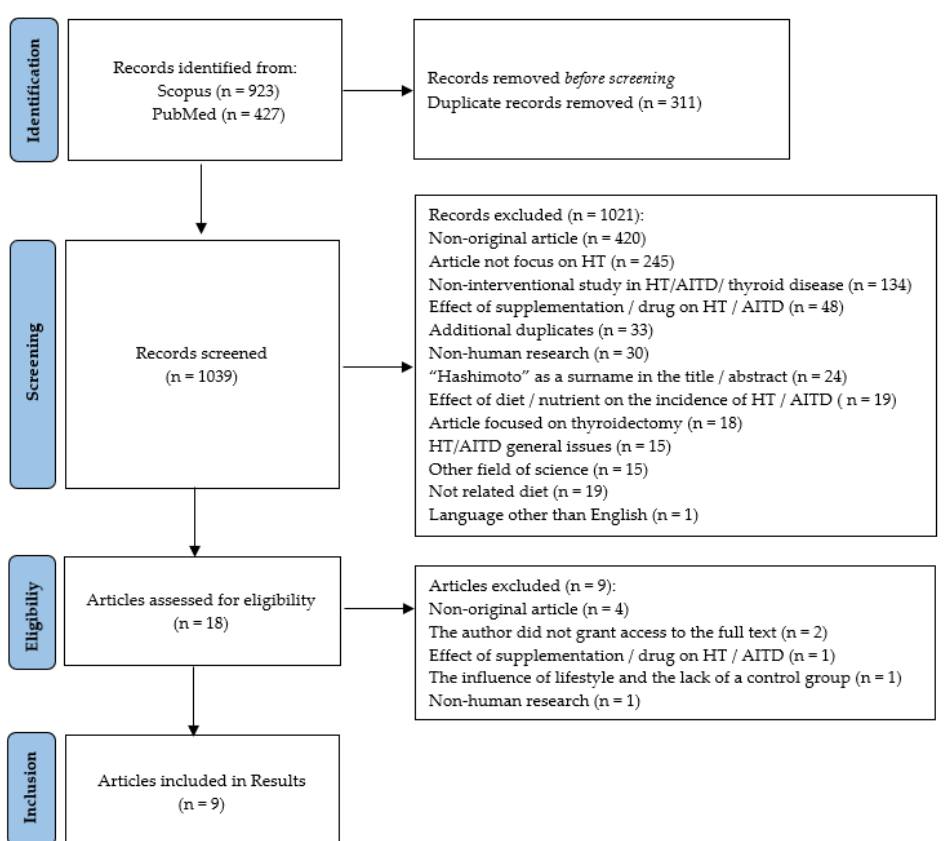
Figure 1. PRISMA flow diagram of the selected and included articles. HT—Hashimoto’s thyroiditis; AITD—autoimmune thyroid disease.